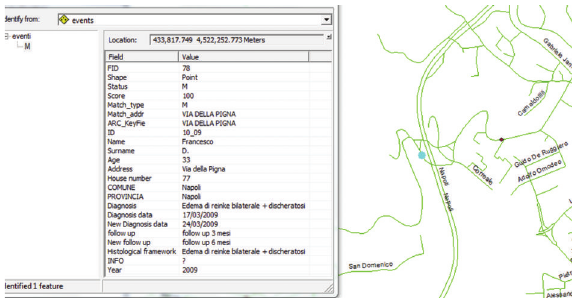
Figure 3: Data associated to an event on the map.